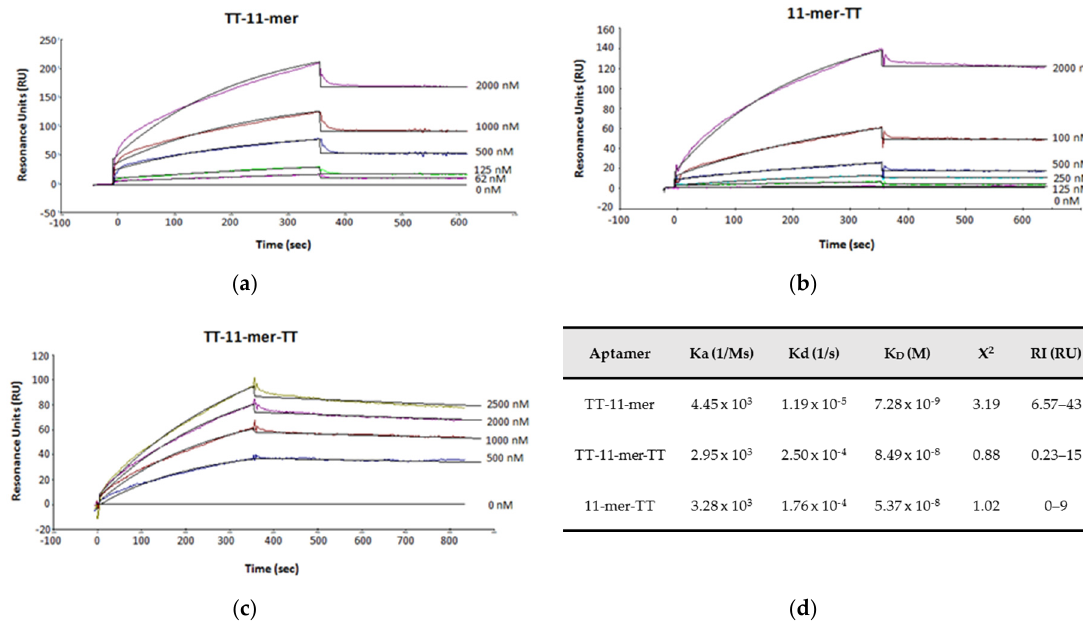
Figure 7. Binding studies with the 11-mer TT derivatives by surface plasmon resonance (SPR). ( a ) TT-11-mer, ( b ) 11-mer TT, ( c ) TT-11-mer-TT. ( d ) Kinetic constants used for K D calculation.